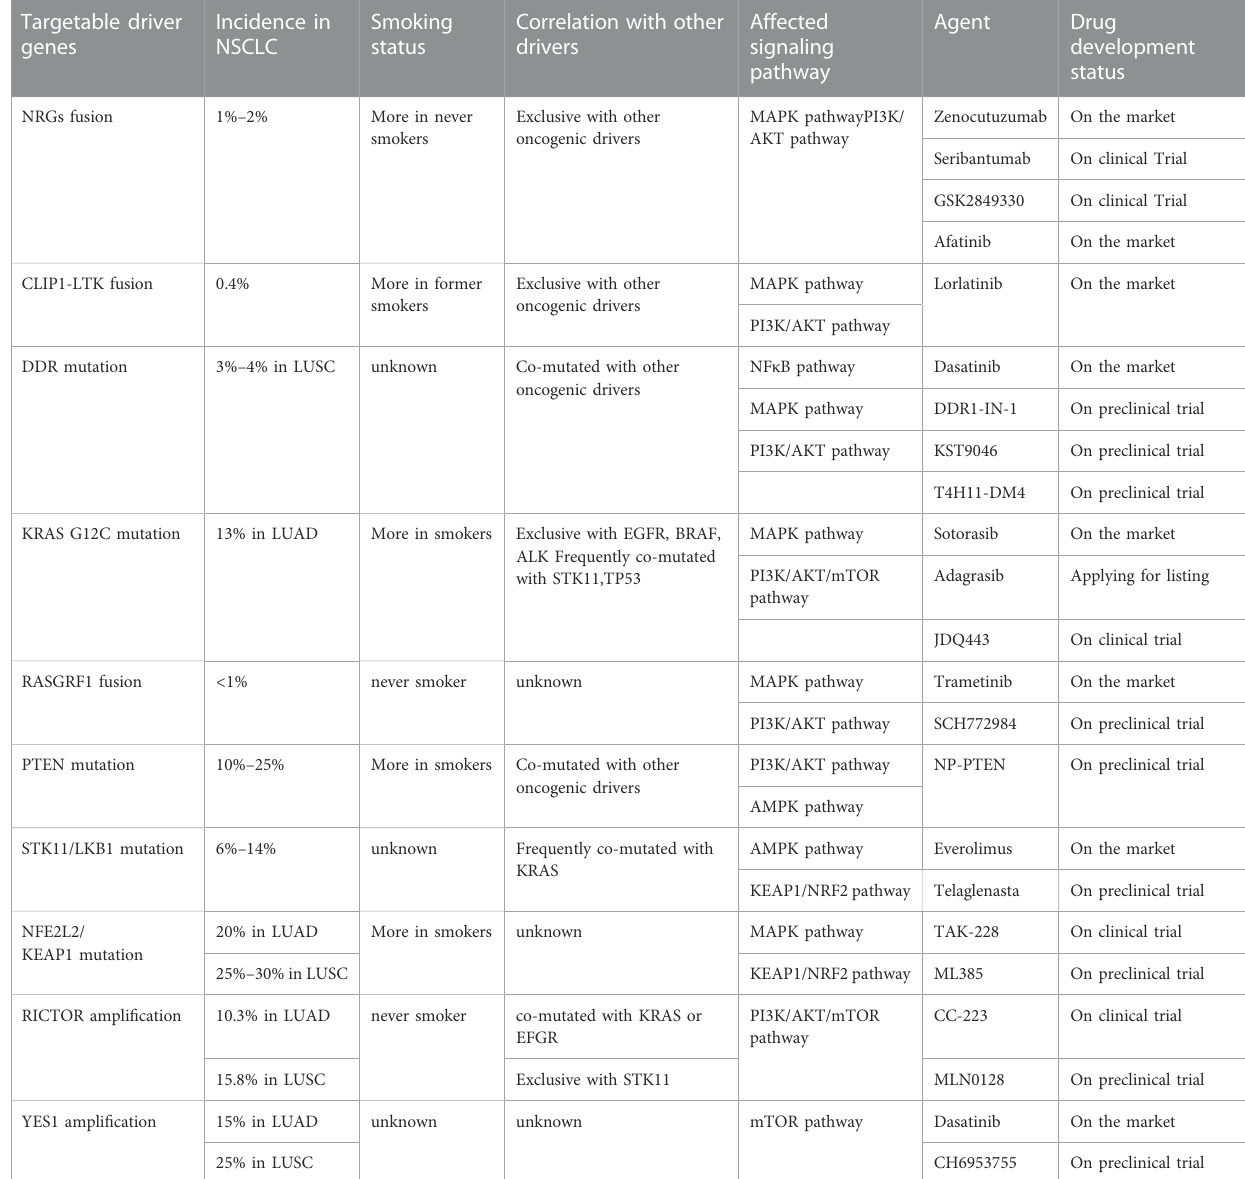
TABLE 2 Features of emerging